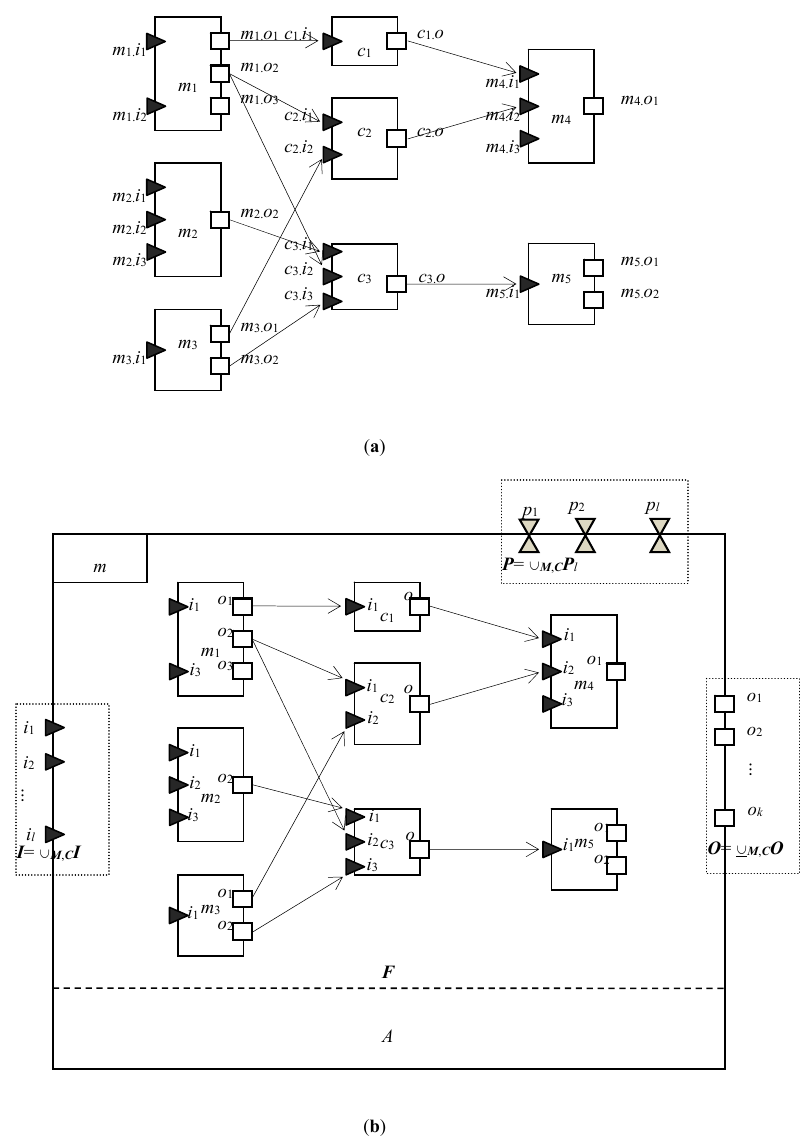
Figure 13. The example of a model graph. ( a ) The example of a model graph; ( b ) The unified view of an integrated model based on